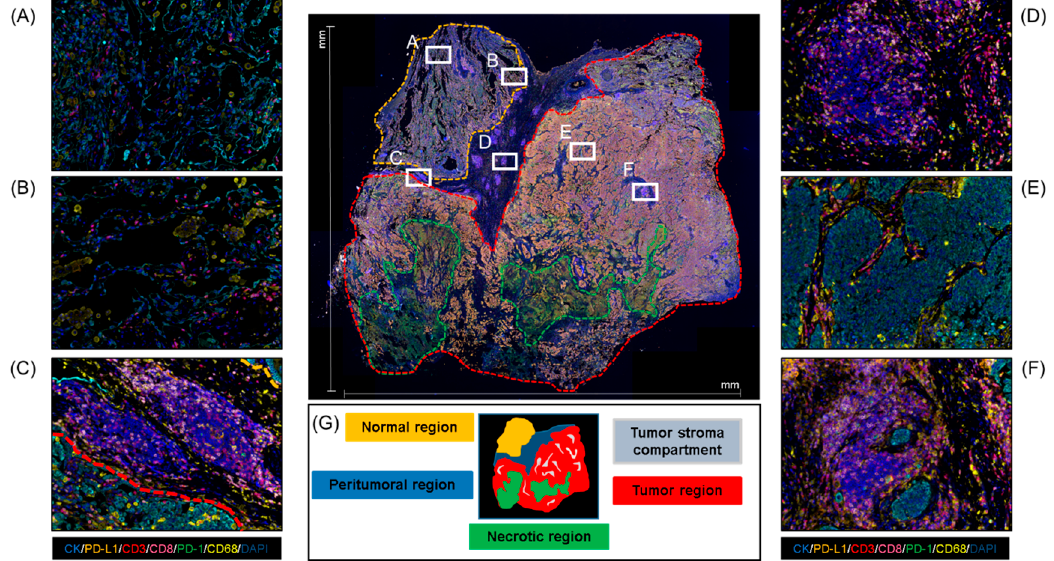
Figure 4. Whole-section sample microphotograph of multiplex IF and the different areas that can be analyzed in this type of material. ( A,B ) Normal regions. ( C ) Peritumoral region. ( D ) Tertiary lymphoid structures. ( E ) Tumor region. ( F ) Aggregate lymphoid region. ( G ) Schematic of regions on a whole-section sample. At 4× magnification of the panoramic view and 20× magnification of the specific regions.